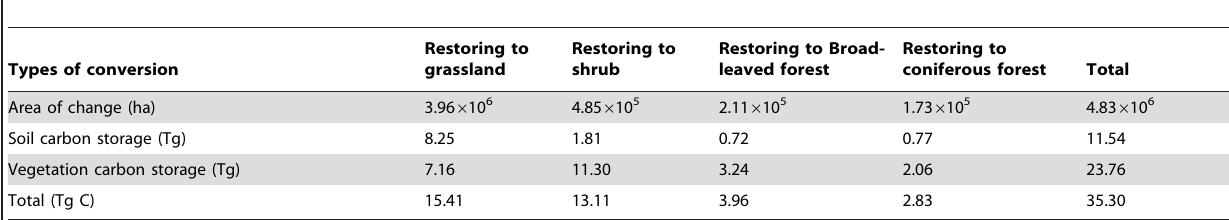
Table 2. Area of cropland converted to forest (grassland) and the carbon sequestration by vegetation, soil and ecosystems in Loess Plateau between 2000 and